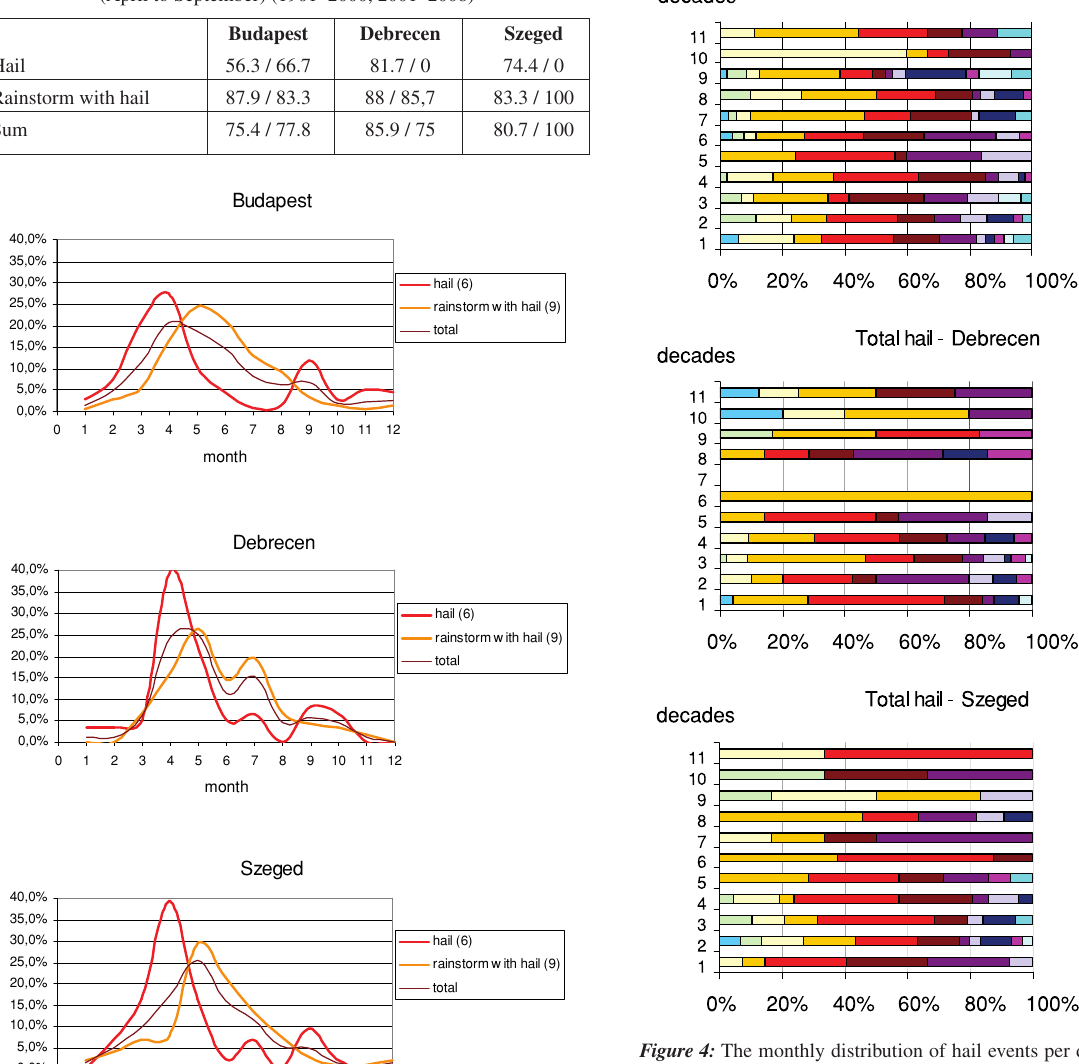
Table 1. The ratio of hail events (%) in the vegetation period (April to September) (1901–2000,